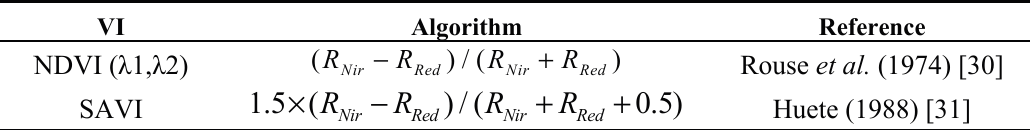
Table 6. Algorithms and references of different spectral